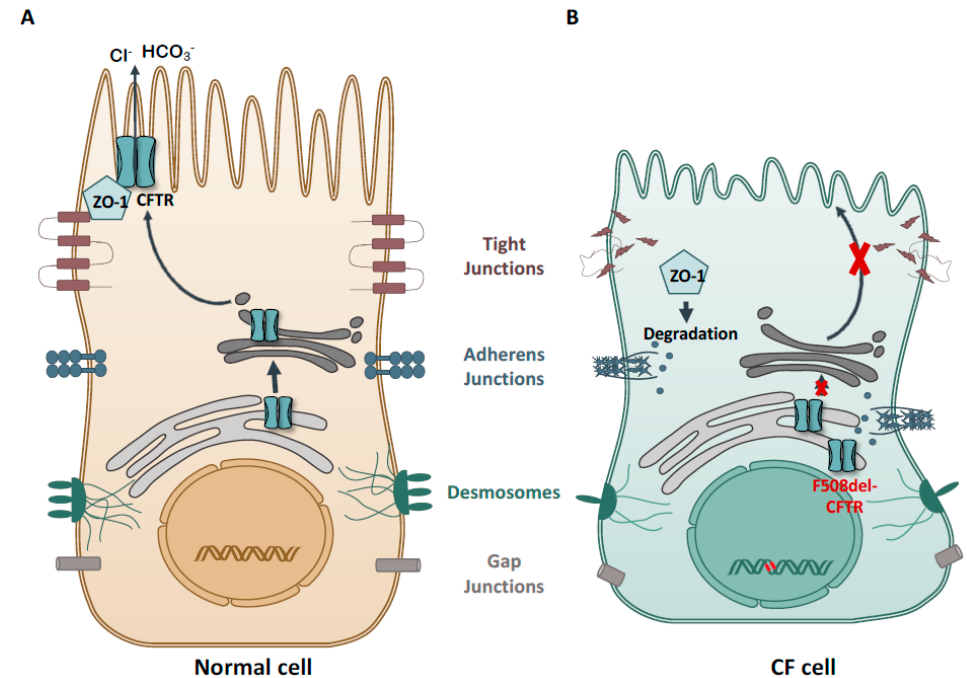
Figure 2. CFTR and its association with cell junctions. ( A ) In normal epithelial cells CFTR expression at the plasma membrane contributes to a correct cell junction integrity and correct architecture of polarized epithelial cells. ( B ) In CF cells, dysfunctional CFTR leads to the disruption of cell junction structures, resulting in reduced epithelial barrier function.